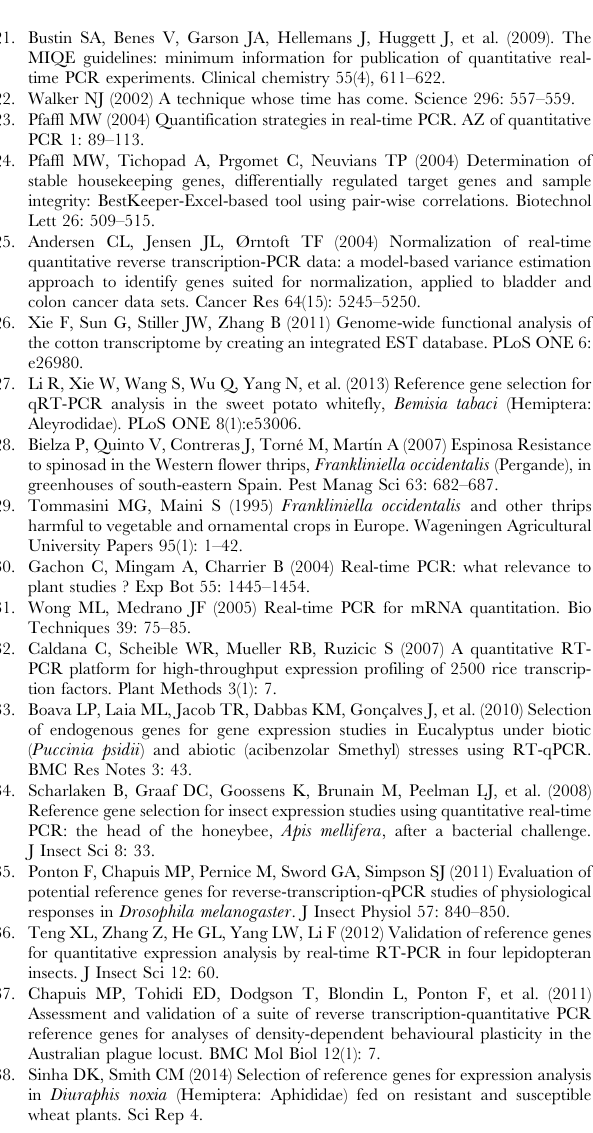
Figure 4. Validation of reference gene selection. A) Relative expression levels of Hop in different developmental stages; B) Exposed to high temperatures; C) Exposed to low temperatures ( P , 0.05, Tukey s-b(k);